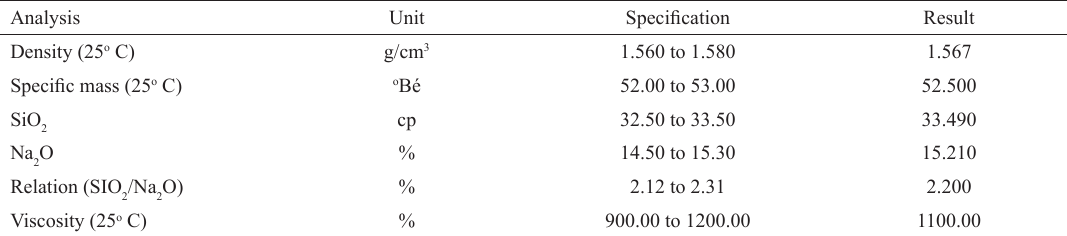
Table 5: Characteristics of sodium silicate